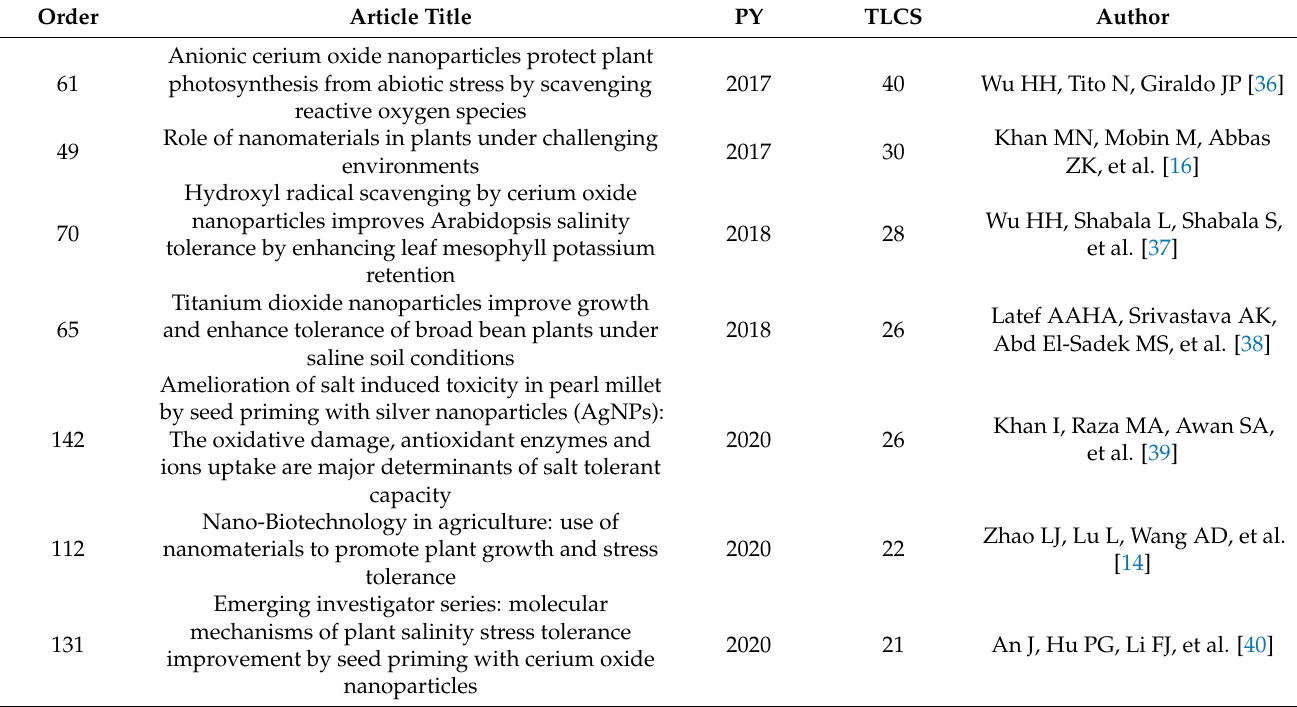
Table 5. Details of the top peer-cited papers in the local